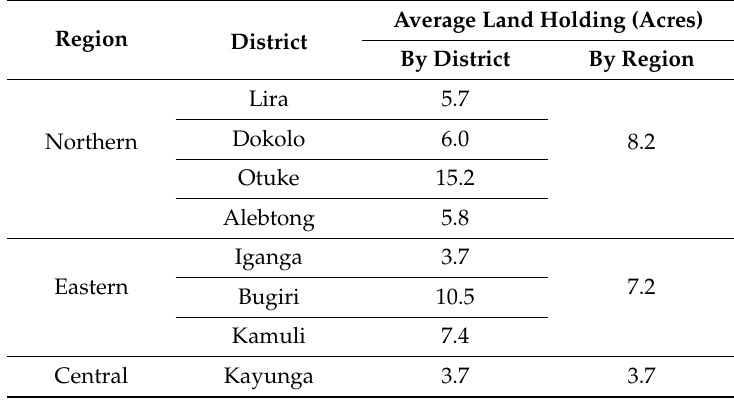
Table 2. Average land holding of the respondents by district and